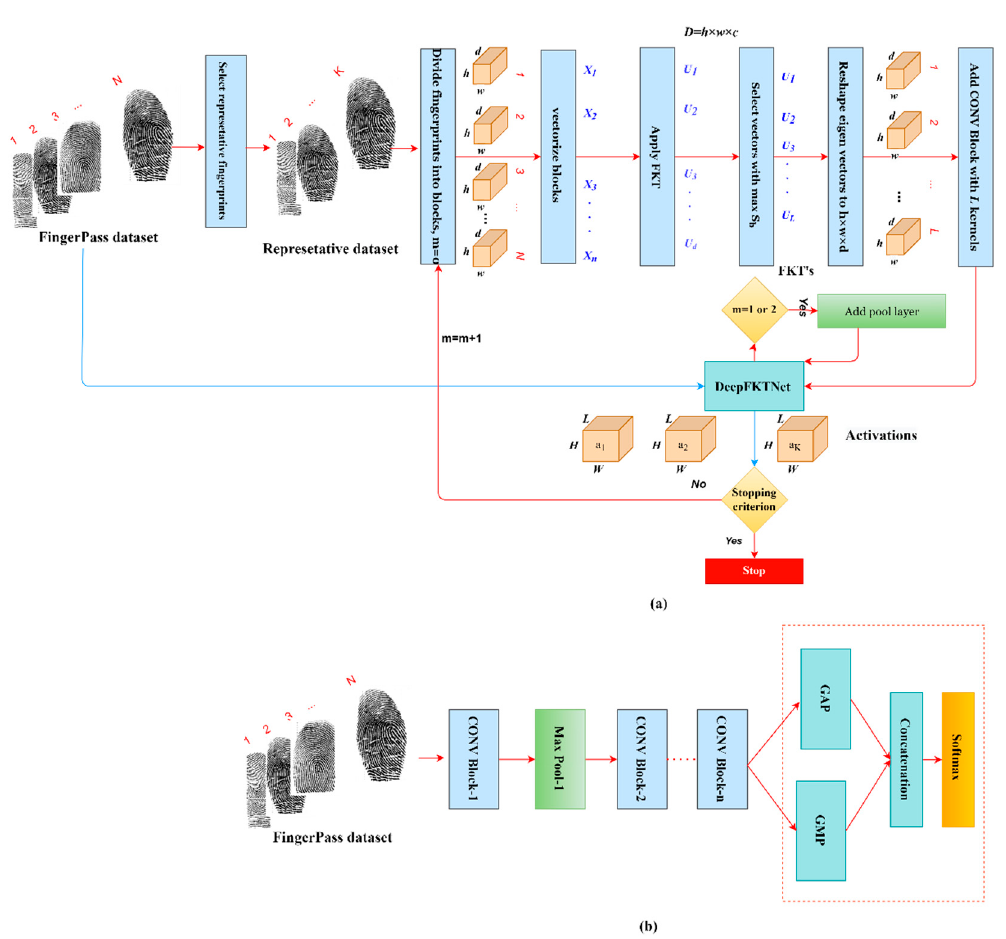
Figure 1. Design procedure of DeepFKTNet; ( a ) design of main DeepFKTNet architecture and ( b ) addition of global pooling and softmax layers and fine ‐ tuning the model.